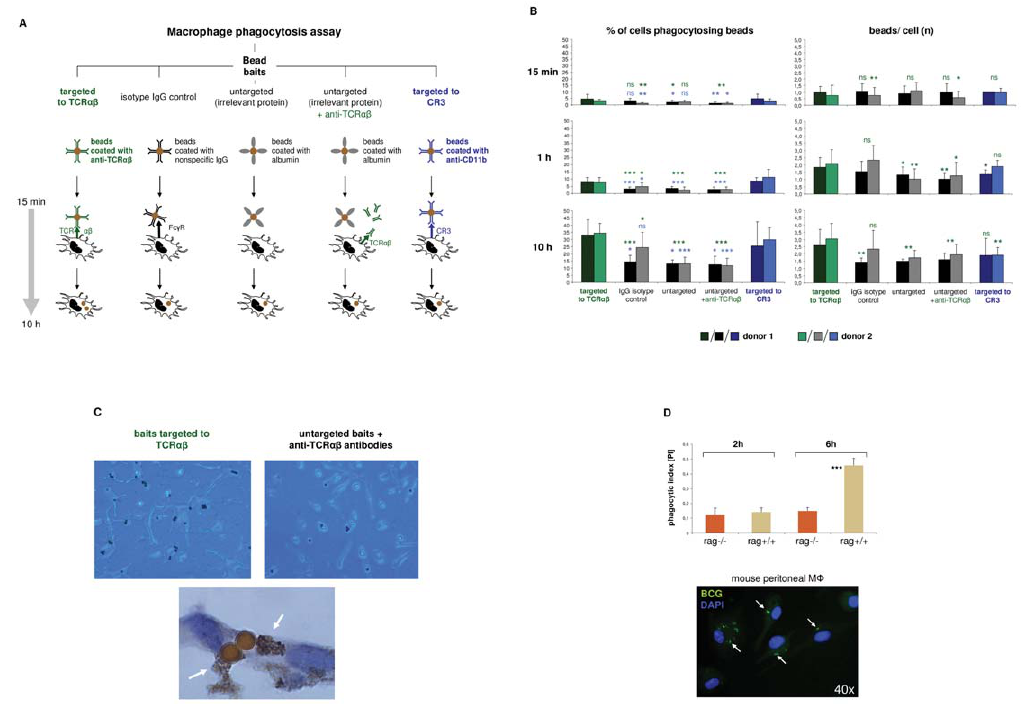
Figure 4. The macrophage TCR ab modulates phagocytosis. (A) Schematic representation of the phagocytosis assay used for targeting of baits to the macrophage TCR ab . IFN c polarized macrophages were challenged with polystyrene bead baits (Ø 4.5 m m) coated with anti-TCR ab antibodies for 15 min, 1 h and 10 h, respectively, and uptake of beads was recorded. Beads coated with nonspecific IgG antibodies, potentially binding to the Fc c receptor (Fc c R), anti-CD11b antibodies targeting the complement receptor 3 (CR3) and albumin (irrelevant protein) served as controls. In addition, macrophages were challenged with uncoupled anti-TCR ab antibodies in the presence of albumin-coated bead baits. ( B ) Enhanced phagocytosis of baits targeted to the macrophage TCR ab . Shown is the time course analysis of the percentage of phagocytosing cells (left) and the bead/cell ratios (right) in IFN c macrophages that were challenged with bead baits as detailed in (A). IFN c macrophages from two healthy donors were incubated with beads (M W :beads = 1:1, 5 m g Ab/10 7 beads) for the indicated timepoints. Quantitation of phagocytosed beads was performed by bright field microscopy of at least 12 randomly selected fields of vision. P values refer to beads targeted to the TCR (green) or the CR3 (blue). *p , 0.05, ** p , 0.01, ***p , 0.001; ns, not significant. ( C ) Representative unstained cytospin preparations (40x) of IFN c macrophages from donor 1 that were challenged with bead baits targeted to the TCR ab (top left) or albumin-coated beads in the presence of uncoupled anti- TCR ab antibodies (control, top right). DAB immunostaining of two adjacent macrophages (bottom, 100x) demonstrates the presence of the TCR ab (arrows) in immediate proximity to two ingested beads that were targeted to this immune receptor. The quantitative analysis of phagocytosed beads from this individual is shown in (B). ( D ) Reduced phagocytosis of M. bovis BCG by macrophages from recombination defective rag1 –/– mice which lack the recombinatorial TCR ab . Thioglycollate-elicited peritoneal macrophages from rag1 –/– mice and rag1 + / + wildtype control mice were infected with FITC-labeled M. bovis BCG (M W : BCG = 1:10) and the phagocytic index was determined at the indicated timepoints by digital analysis of fluorescent images. ***p , 0.001. The data are based on the quantitative analysis of 7 pooled rag1 –/– mice and an equal number of rag1 + / + mice. The fluorescent image (bottom) representatively shows rag1 + / + peritoneal macrophages after 6 h of infection with BCG . Arrows highlight ingested BCG mycobacteria. Nuclei, DAPI (blue).